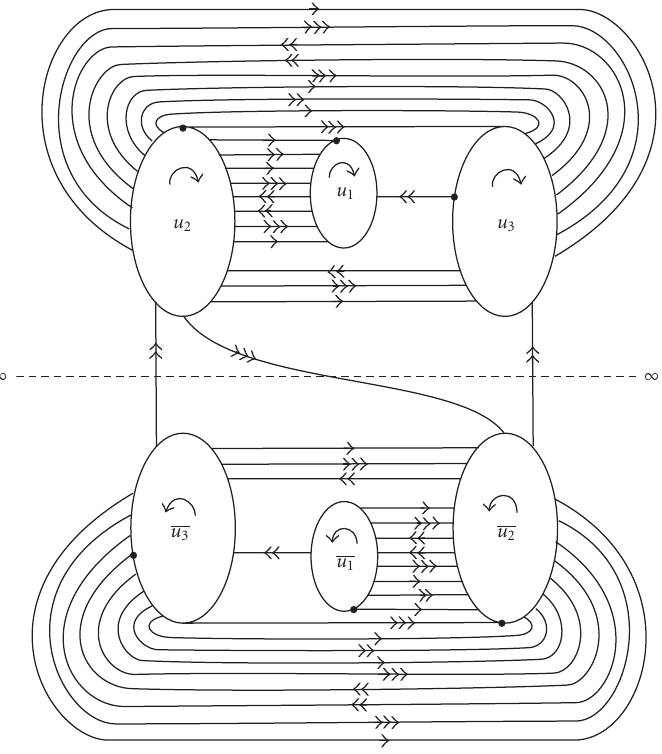
Figure 3.1. An irreducible Heegaard diagram of genus three for M 3